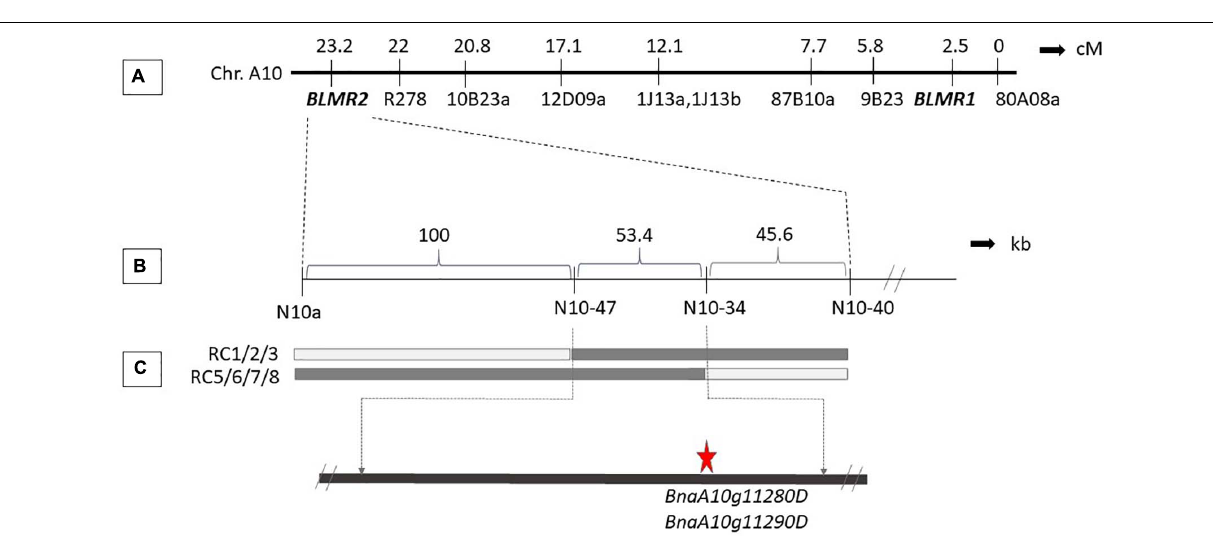
FIGURE 2 | Genetic and physical map of BLMR2 locus on Chromosome A10 of Brassica napus . Genetic map showing BLMR1 and BLMR2 (Long et al., 2011; A ). The flanking SSR and SCAR markers used in the fine mapping of BLMR2 (B) . Molecular marker data of the recombinants with resistant phenotype showing overlapping BLMR2 region corresponding to 57.3 kb physical interval. The candidate BLMR2 gene is indicated (C)